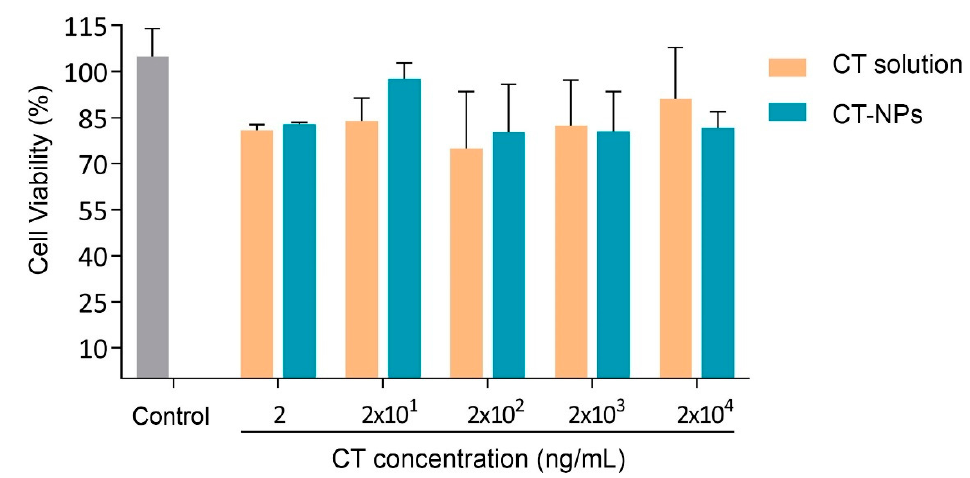
Figure 3. WISH cell viability upon exposure to different concentrations of CT solution and CT-NPs. Values are expressed as the mean ± S.D. (n = 3).